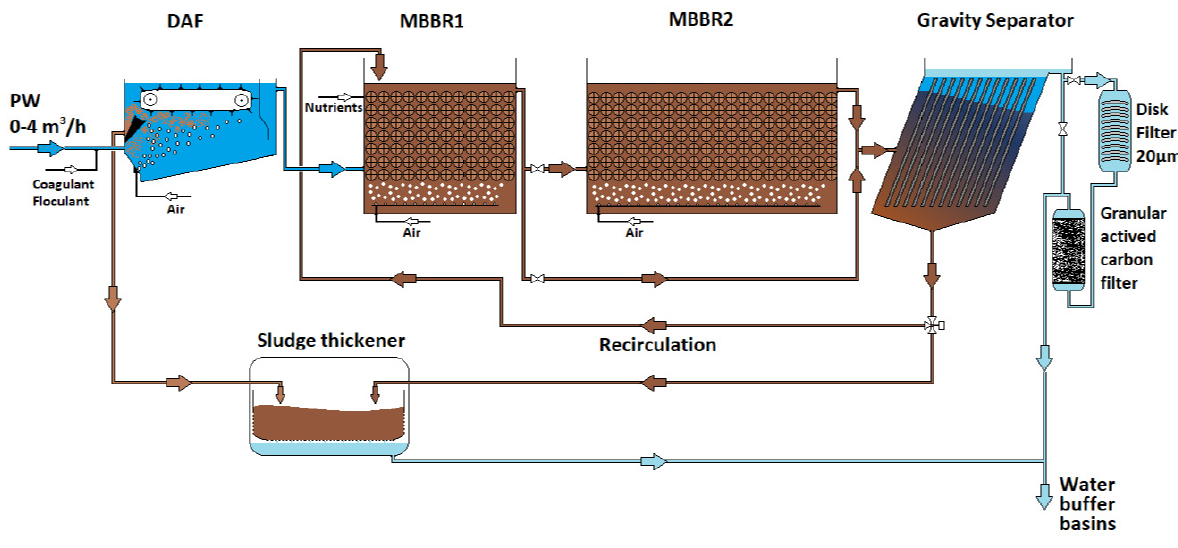
Figure 1. BIOMEM pilot block flow diagram.